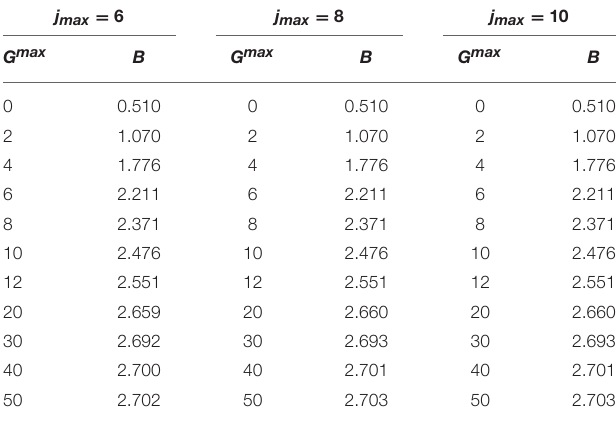
TABLE 10 | The 3 3 H binding energy B (in MeV) as function of j max and G max , calculated with the Gaussian potential model of Clare and Levinger [18], using N max 20, and γ 4 fm − 1 . = =